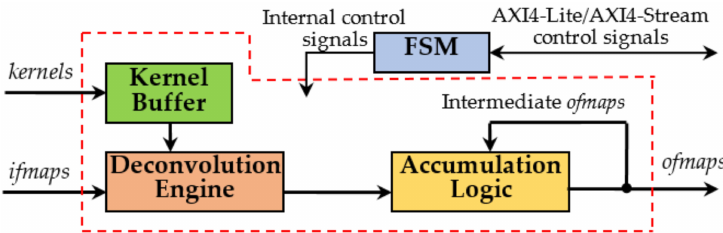
Figure 2. The top-level architecture of the Deconvolution Layer Processing Element. FSM: The Finite State